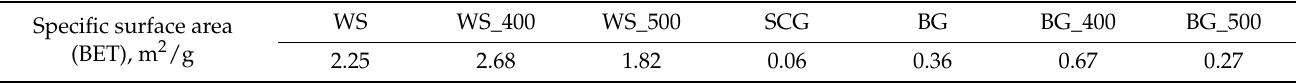
Table 3. Specific surface area (BET) of studied feedstock and biochars (obtained after the pyrolysis). Specific surface